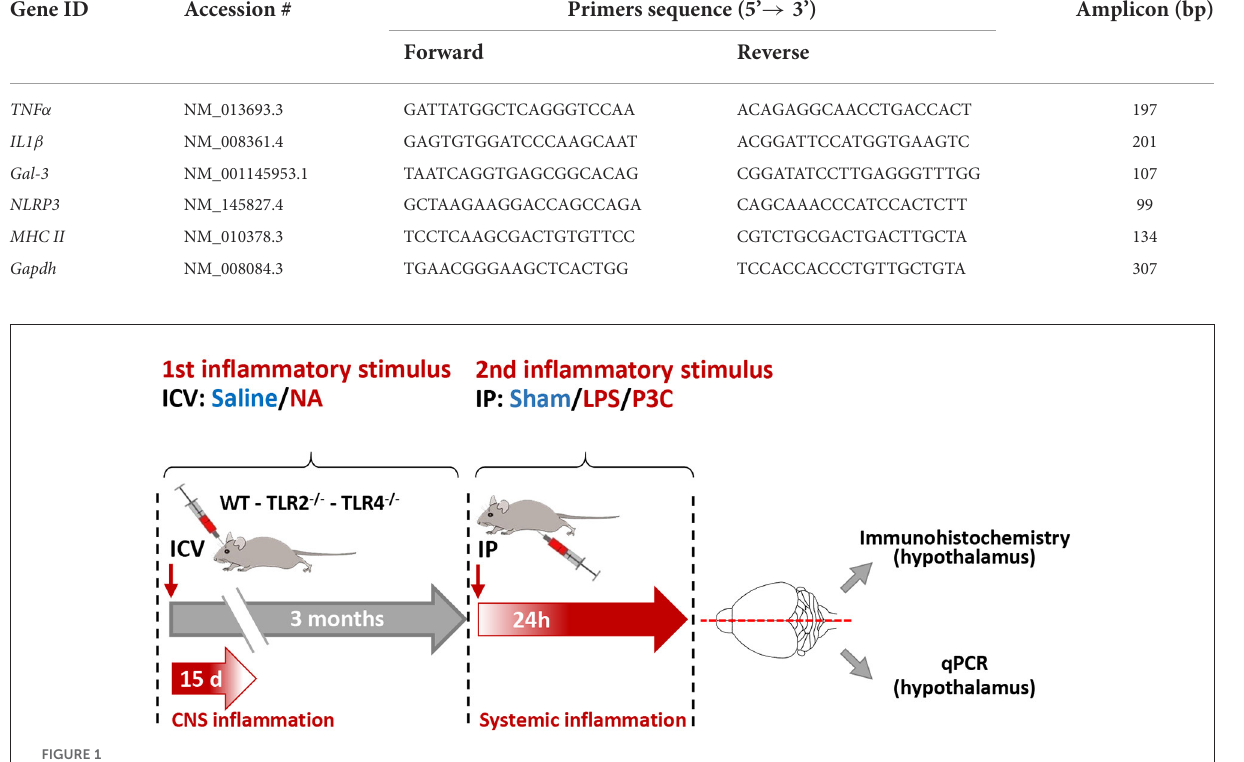
FIGURE1 Scheme of the experimental design. Wild type (WT), TLR2 and TLR4 mutant mouse strains were subjected to a first inflammatory stimulus consisting of an ICV injection of neuraminidase (NA) or saline (as control). NA-induced inflammation lasts about 15 days. Three months later a second inflammatory stimulus was applied, consisting of an intraperitoneal (IP) injection of LPS or P3C; saline was injected to control animals (sham). Twenty-four hours after this second stimulus the animals were anesthetized, perfused with saline and their brains removed. The brains were divided by the mid-sagittal line; the right half was used for immunohistochemistry, and the left half was used for RNA isolation and gene expression quantification by qPCR. These studies focused on the